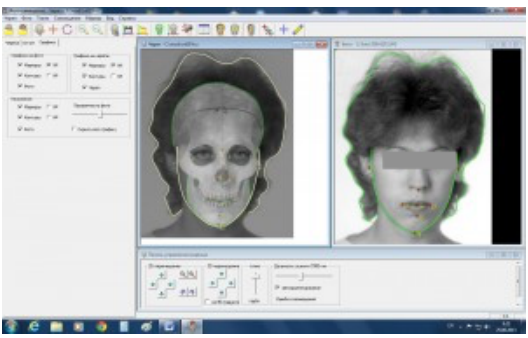
Figure 7. Identification